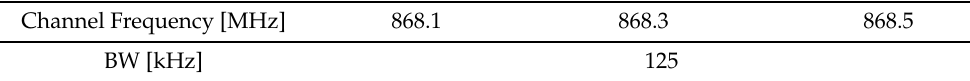
Table 2. EU868 default channels.